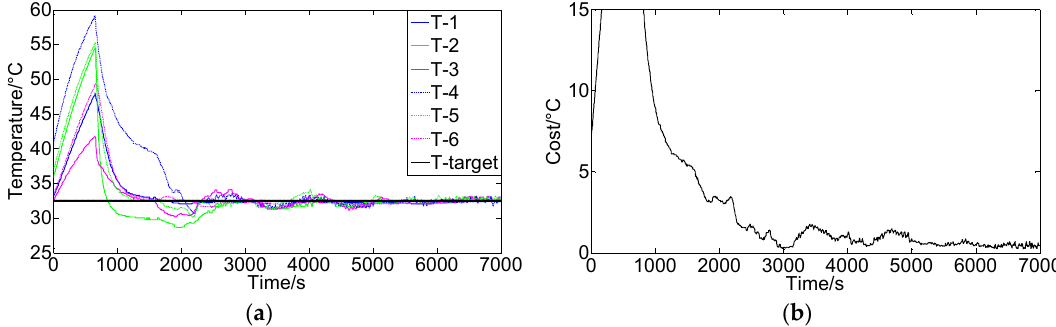
Figure 9. ( a ) Control results of the FCPIDNN controller when all fans were working (target temperature is 32.5 °C); ( b ) Variation of the square root of the cost function ( (cid:3493) J( n )).